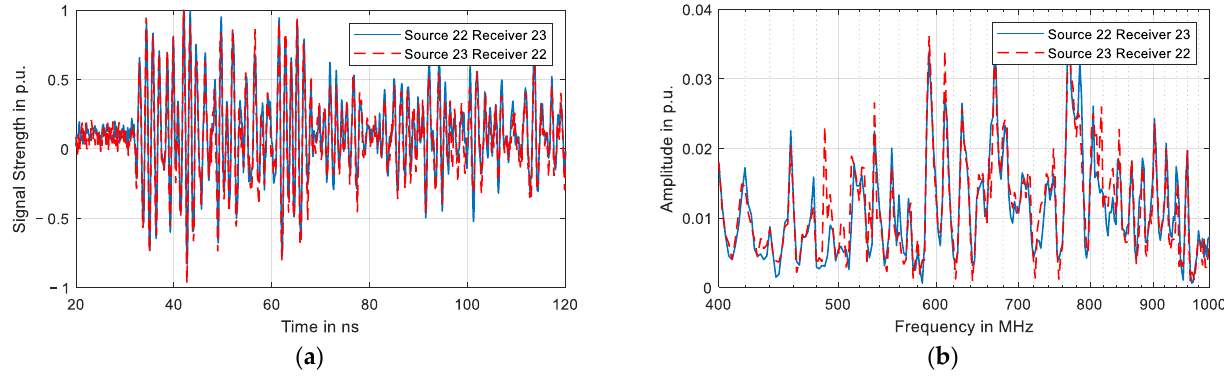
Figure 3. Reciprocity test of signals when the source and receiver are reversed: ( a ) time-domain; ( b ) frequency-domain.